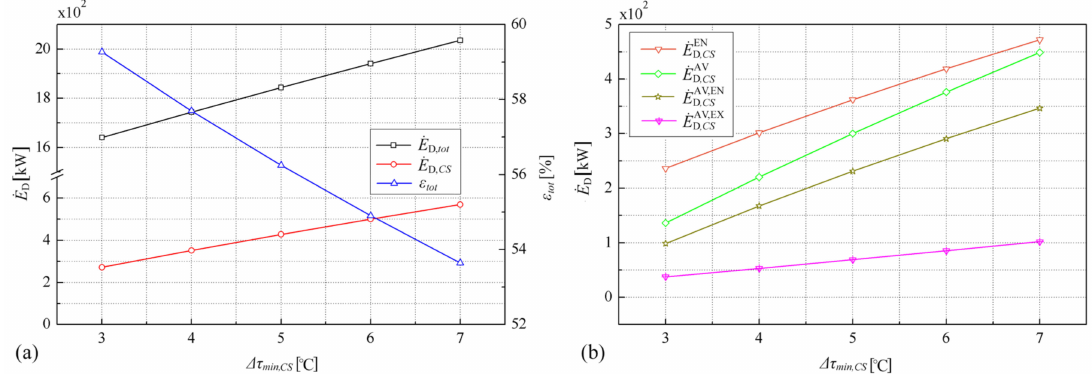
Figure 4. E ff ects of pinch temperature in cold storage: ( a ) conventional exergy analysis results; ( b ) advanced exergy analysis results.